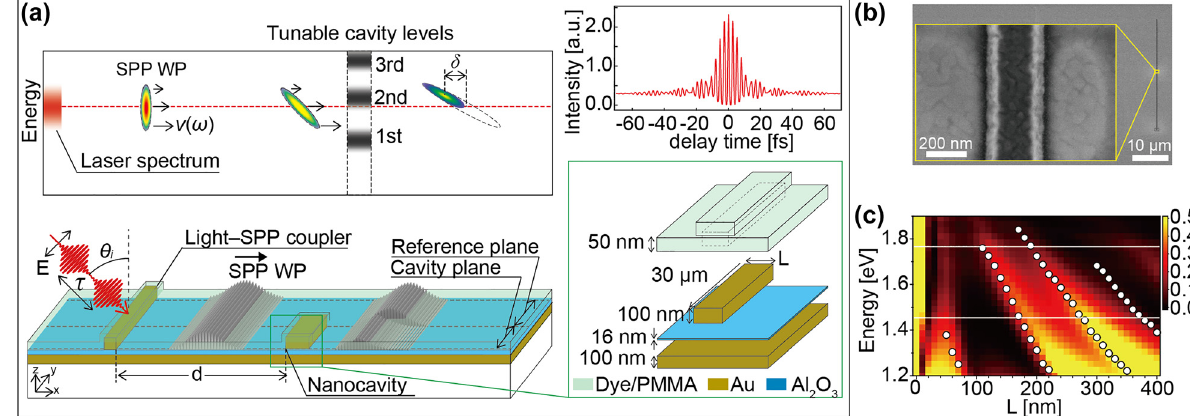
Figure 1: Concept of resonant interaction of SPP WP with nanocavity, overview of the experimental setup, and spectral property of the nanocavity.(a)SchematicofsamplecontainingMIMnanocavityandlight – SPPcoupler.Thesamplesurfaceiscoveredwithadye-dopedPMMA thin film. Irradiation with 10 fs laser light launches the SPP WP from the coupler. The SPP WP possesses a spectral distribution comparable to that of the laser light immediately after the excitation. Resonant interaction with an MIM-NC, which has a few discretized levels of the eigenmode, results in a spectrally clipped transmission, leading to a spatial shift ( δ ) in the position of the intensity peak of the WP. A fringe- resolved autocorrelation (FRAC) trace of the fs-laser obtained by placing a thin β -BBO crystal at the sample position is also shown. (b) SEM imageofMIM-NCwithalengthof L =220nm.(c)Two-dimensionalplotoftransmittancespectraofSPPplottedasfunctionoflengthofMIM-NC ( L ; 10 – 400 nm) and energy (see Supplementary Figure S1 for details). The four sets of solid circles indicate the peak energies of the fi rst- to fourth-order eigenmodes of the MIM-NC. The two white lines indicate the upper and lower spectral limits of the excitation